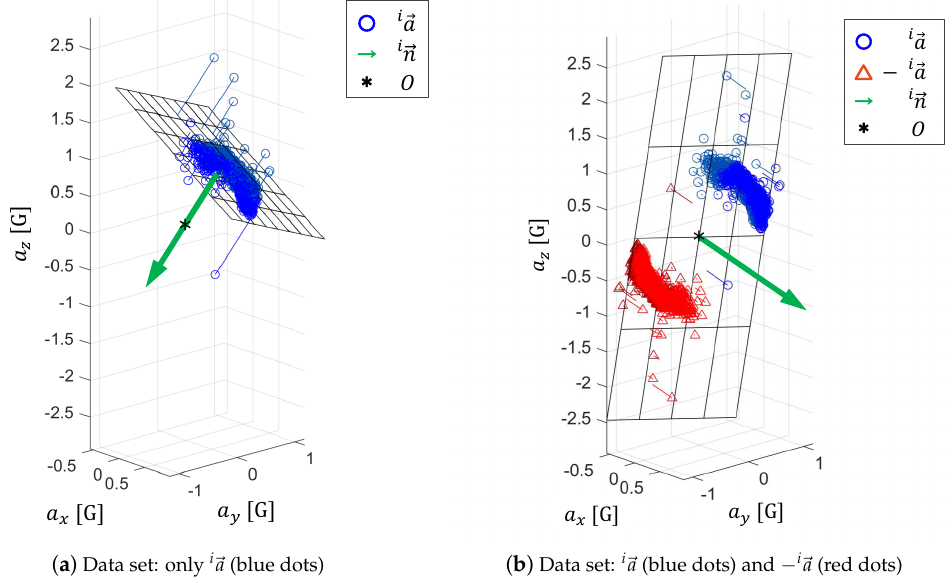
( a ) Data set: only i (cid:126) a (blue dots) Figure 2. Estimated sagittal plane and normal vector extraction from PCA, adding origin